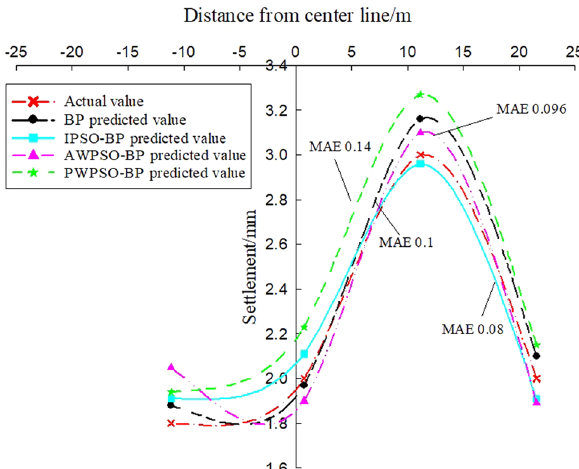
Figure 14. Longitudinal measuring points on the right.